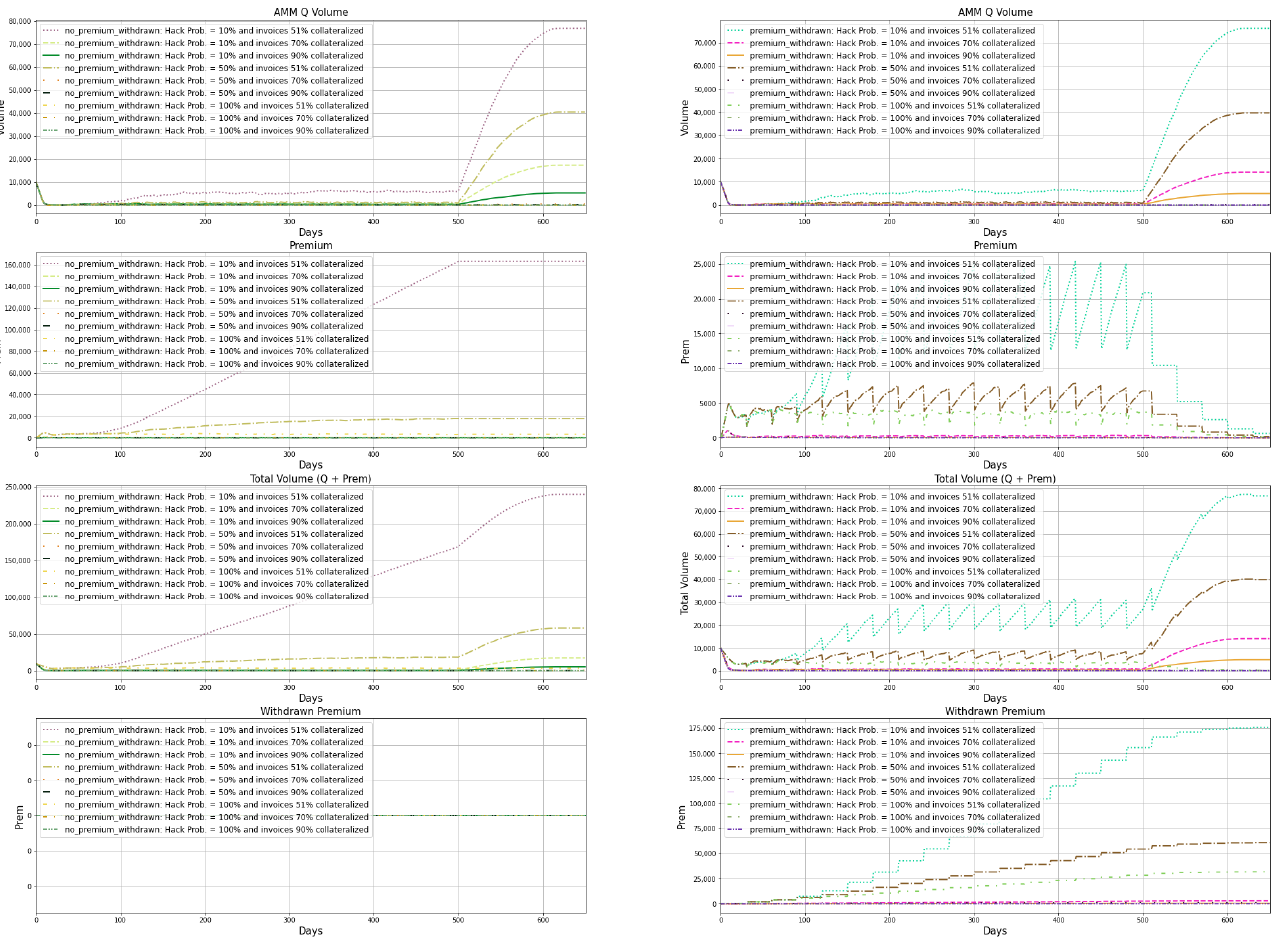
Figure 8. rkAMM Curves from simulation of hack scenario and 30 days of withdrawal